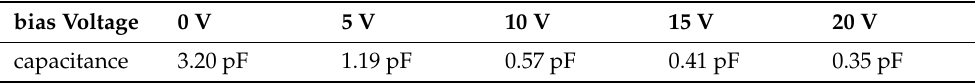
Figure 6. ( a ) the experiment set up illustration; ( b ) the fabricated metamaterial sample consisting of double-cross, varactor diode and strip line structures; ( c ) the y-polarized transmission and ( d ) the x-polarized transmission of the metamaterial at different V b ; ( e ) the change of the transmission peak (red triangle: peak frequency; short bar: dip frequency); ( f ) the peak frequency and peak-to-dip ratio at different V b (black square: peak frequency; red start: peak to dip ratio). Table 1. Relation between the applied voltage and capacitance of the varactor